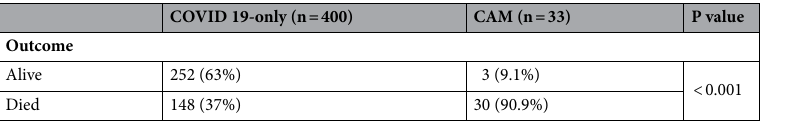
Table 6. Outcome among enrolled patients. Data expressed as frequency (percentage). P value was significant if < 0.05. Data was compared by Chi-square test.